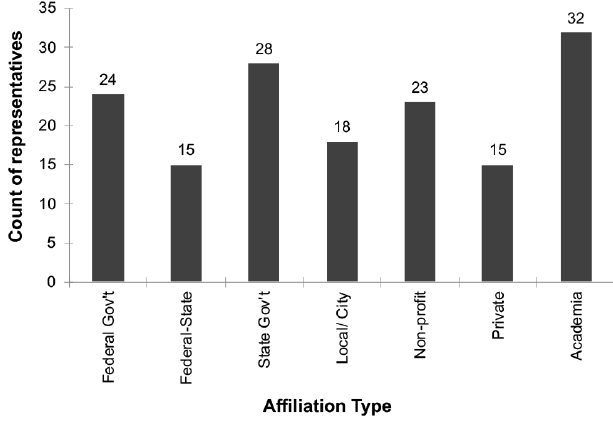
Fig. 5 . Background of co-creators operationalizing resilience for shorelines in New York State. A count of representatives (n = 155) is provided to depict the diversity of affiliations of co- creators. Numbers on top of bars represent the number of co- creators representing an affiliation type. The Federal-State category listed includes organizations/programs that are jointly funded or administered by a federal and a state